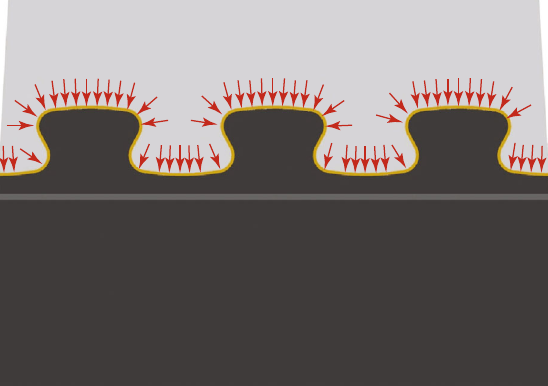
Figure 6: Schematic diagram of stress distribution along the slit.